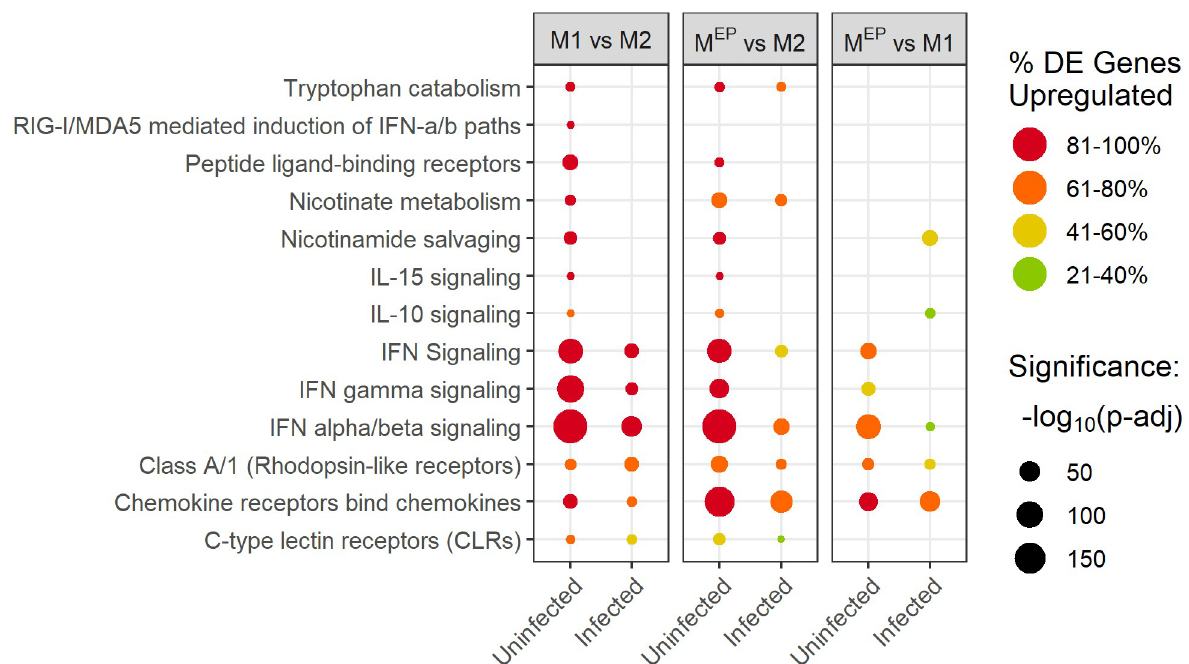
Fig 2. Immune and other pathways showing primed activation. The colour of the dots indicates the percentage of the differentially expressed genes found in the pathway which were upregulated: pathways that were largely upregulated are red, while pathways that were largely downregulated are green. The size of the dots indicates the significance level of the pathway enrichment, -log 10 (p-adj value), such that larger dots have smaller p-values (e.g. 150 refers to the p-value adjusted using the Bonferroni correction for multiple testing, p-adj, of 10 − 150 ). Only pathways with an adjusted p-value < 0.05 are